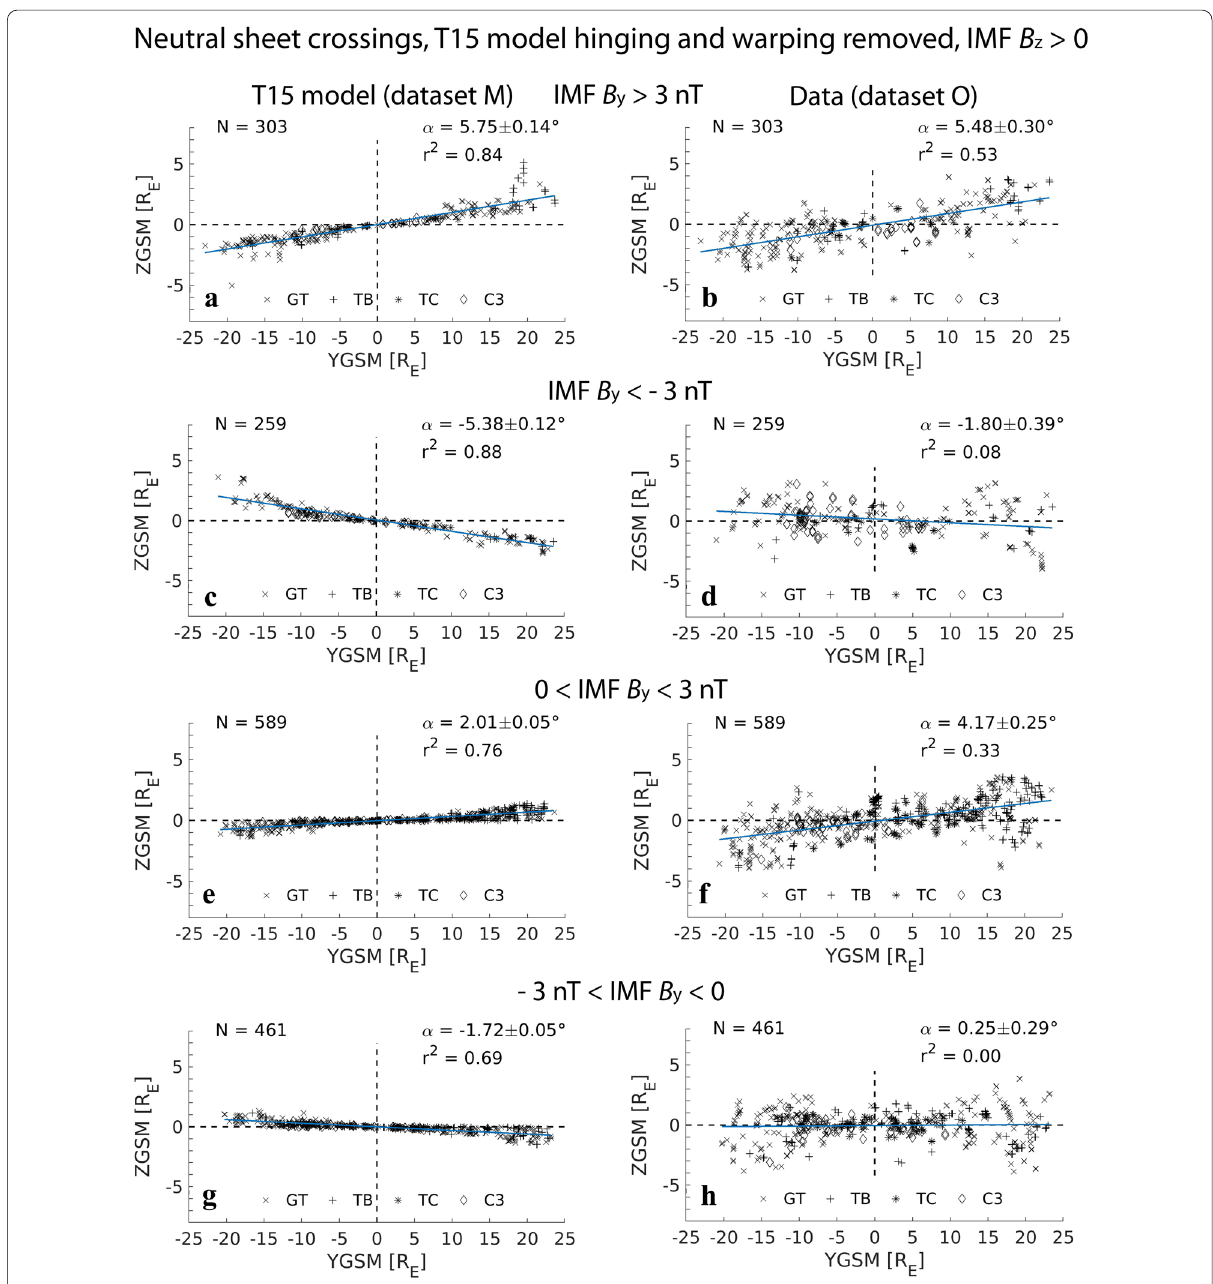
Fig. 2 Locations of the neutral sheet crossings in the GSM YZ plane for IMF B z > 0 conditions and different IMF B y conditions after removal of the hinging and warping effects according to the T15 neutral sheet model. Left: T15 model (dataset M). Right: data (dataset O). GT THEMIS‑B, TC THEMIS‑C and C3 Cluster 3. In each panel, N marks the number of the neutral sheet crossings, the blue line a linear regression and = = the angle α the angle between the YGSM axis and the regression line indicating the rotation of the neutral sheet (increases from the positive YGSM axis toward the positive ZGSM axis). r 2 is the quality indicator of the regression (square of the Pearson’s correlation coefficient). The ZGSM scale has been zoomed in to magnify the